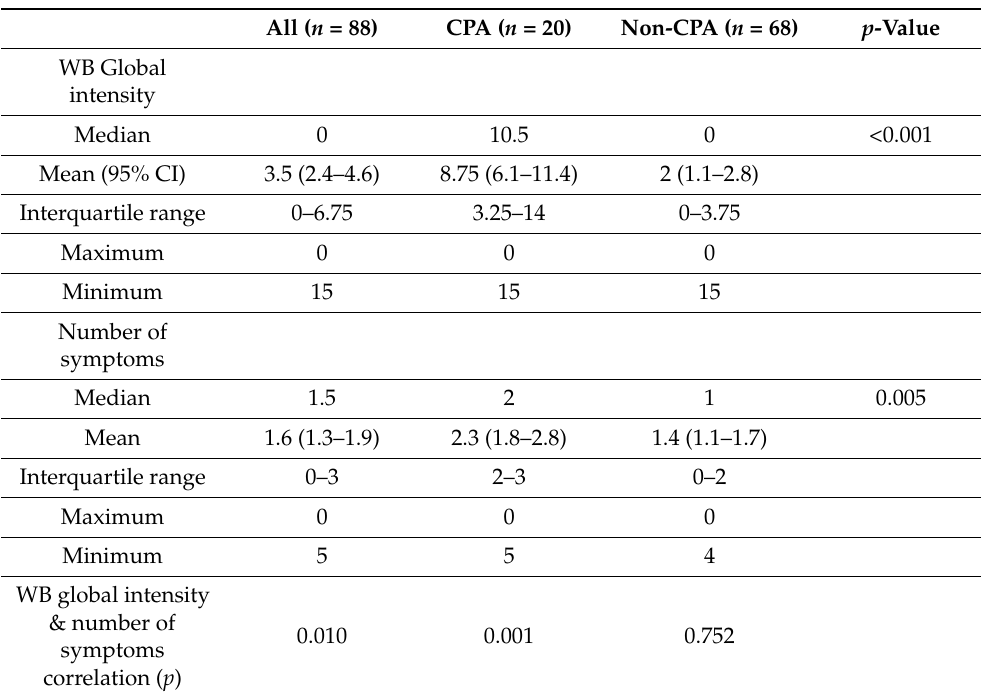
Table 3. Western blot global intensity and number of symptoms in CPA and non-CPA groups.